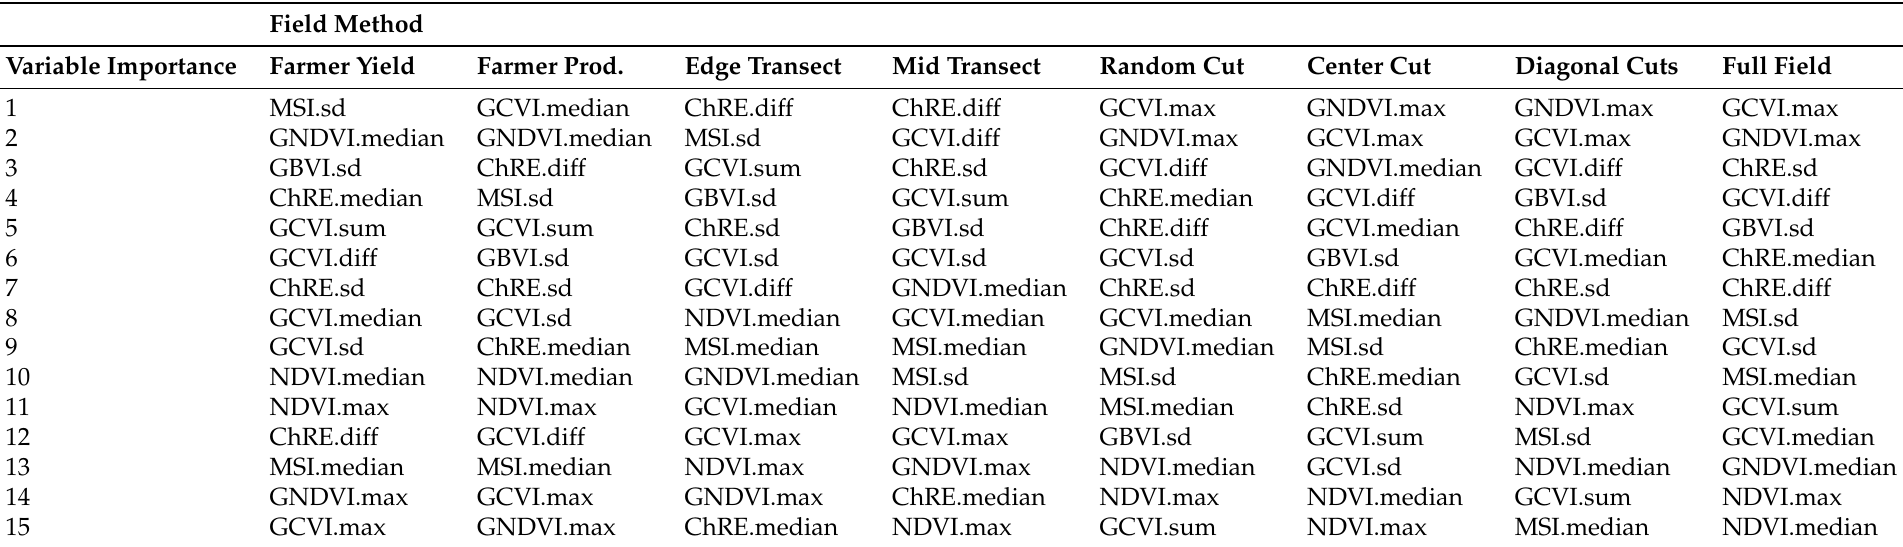
Table A1. The variables of importance by field measurement method for Random Forest averaged across the five fold cross